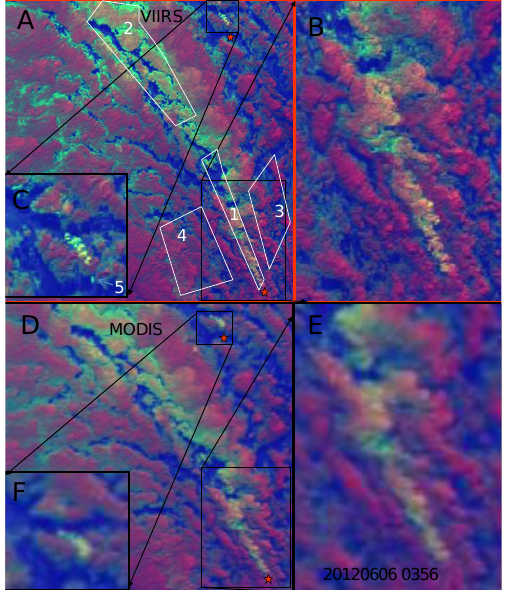
Fig. 3. Same as Fig. 1, but showing a pollution track from a coal power plant in Australia, as seen by VIIRS (03:56UT, panel A ) and MODIS (04:05UT, panel D ) overpasses on 6 June 2012, in an area of 163km × 154km centered at 32.88 ◦ S, 149.20 ◦ E. The red stars show the origination points of a pollution track and a plume of smoky clouds from a small hot spot. These two features are magnified to VIIRS full resolution in panel (B) in an area of 54km × 58km centered at 33.17 ◦ S, 149.90 ◦ E and (C) in an area of 20km × 18km centered at 32.27 ◦ S, 149.43 ◦ E, respectively. The same magnification is applied to the MODIS image in panels (E) and (F) .